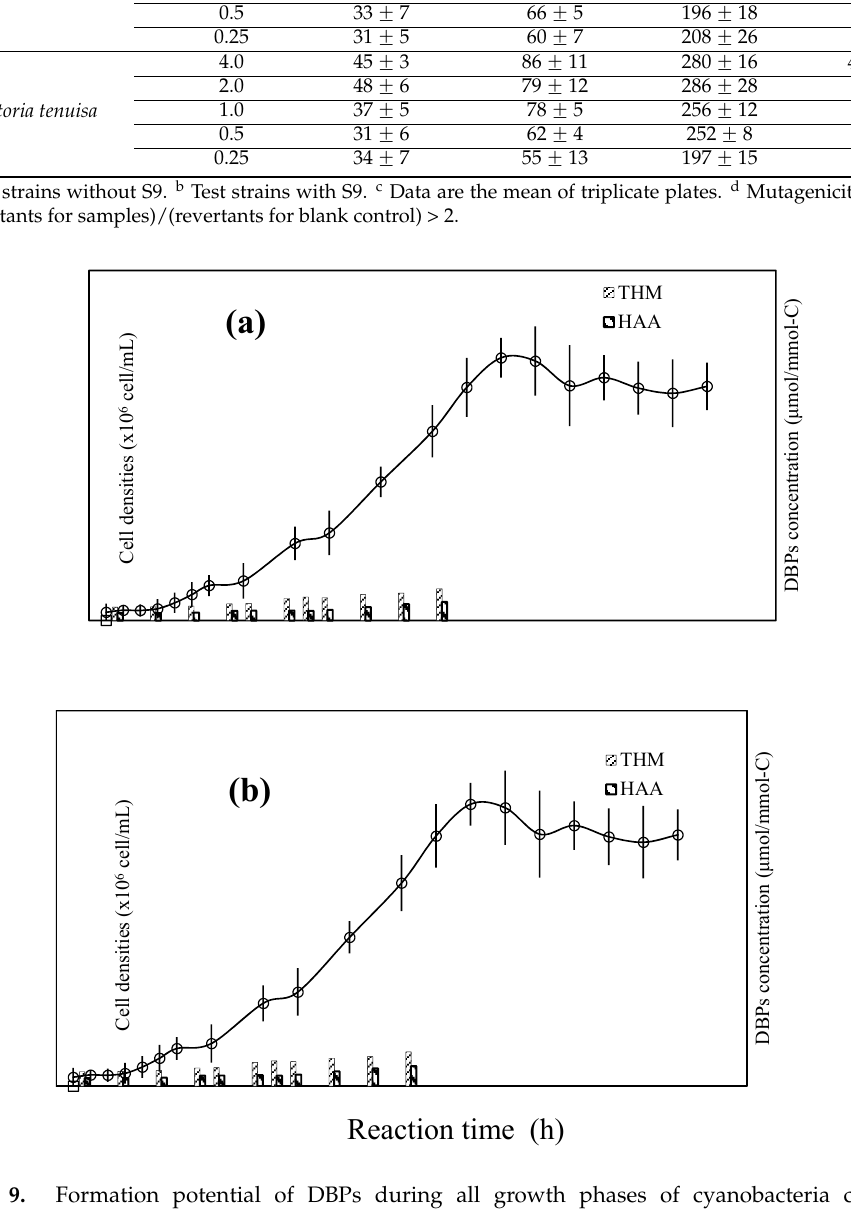
13 Table 2. Mutagenic activity of cyanobacterial EPS extracts in TA98 and TA100